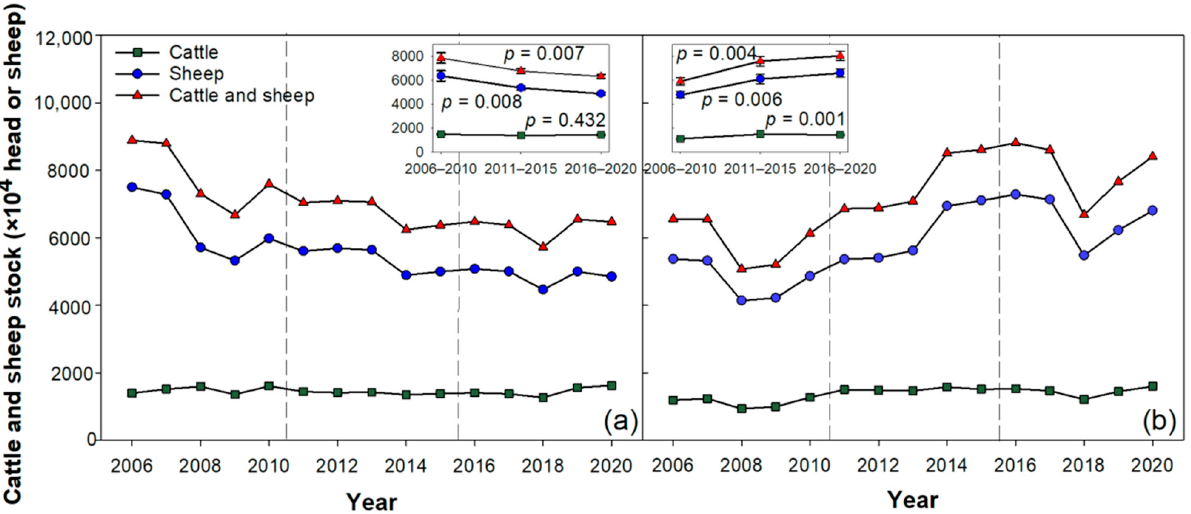
Figure 4. Yearly changes in the numbers of cattle and sheep in pastoral ( a ) and semi-pastoral ( b ) regions of China from 2006 to 2020. regions of China from 2006 to